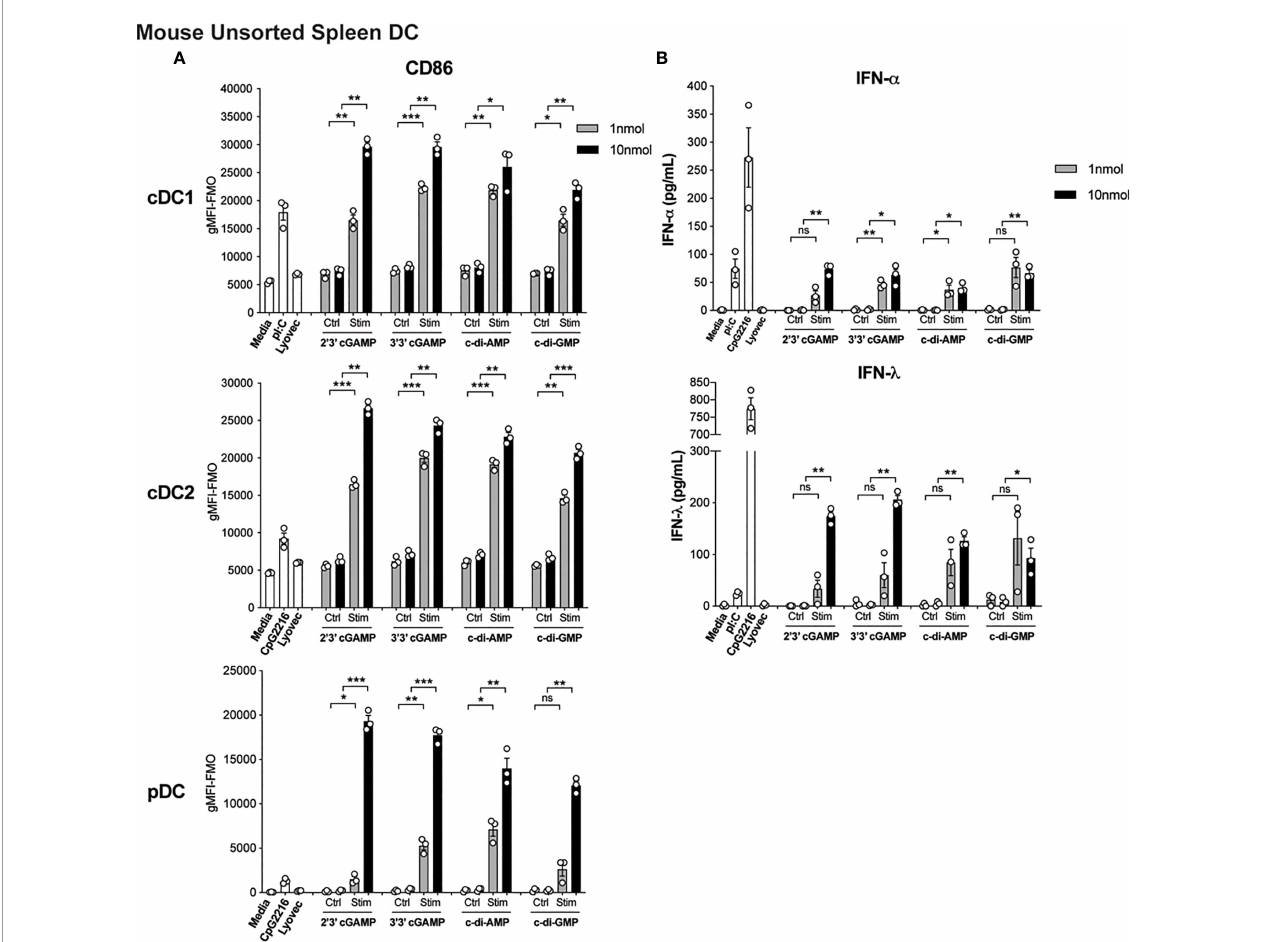
FIGURE 1 | Triggering STING with CDNs induces potent activation and IFN production in mouse DCs. Bulk splenic mouse DCs were stimulated with 1 or 10 nmol 2 ’ 3 ’ cGAMP, 3 ’ 3 ’ cGAMP, c-di-AMP or c-di-GMP complexed with lyovec, their respective linearized control ligands (Ctrl) complexed with lyovec, lyovec alone, 0.5 m M CpG2216 or 100 m g/mL pI:C for 18 h. (A) CD86 expression on DC subsets was determined using fl ow cytometry. Bar graphs represent the mean difference between geometric mean fl uorescence intensities (gMFI) of stained samples and fl uorescence minus one (FMO) controls ± SEM from 3 biological replicates (pool of 2 mice per replicate). (B) IFN production in cell culture supernatants were analysed by ELISA. Bar graphs represent mean ± SEM from 3 biological replicates (pool of 2 mice per replicate). Statistical analyses were performed using two-tailed Paired Student ’ s t test where * P < 0.05, ** P < 0.01, *** P < 0.001 and ns, not signi fi